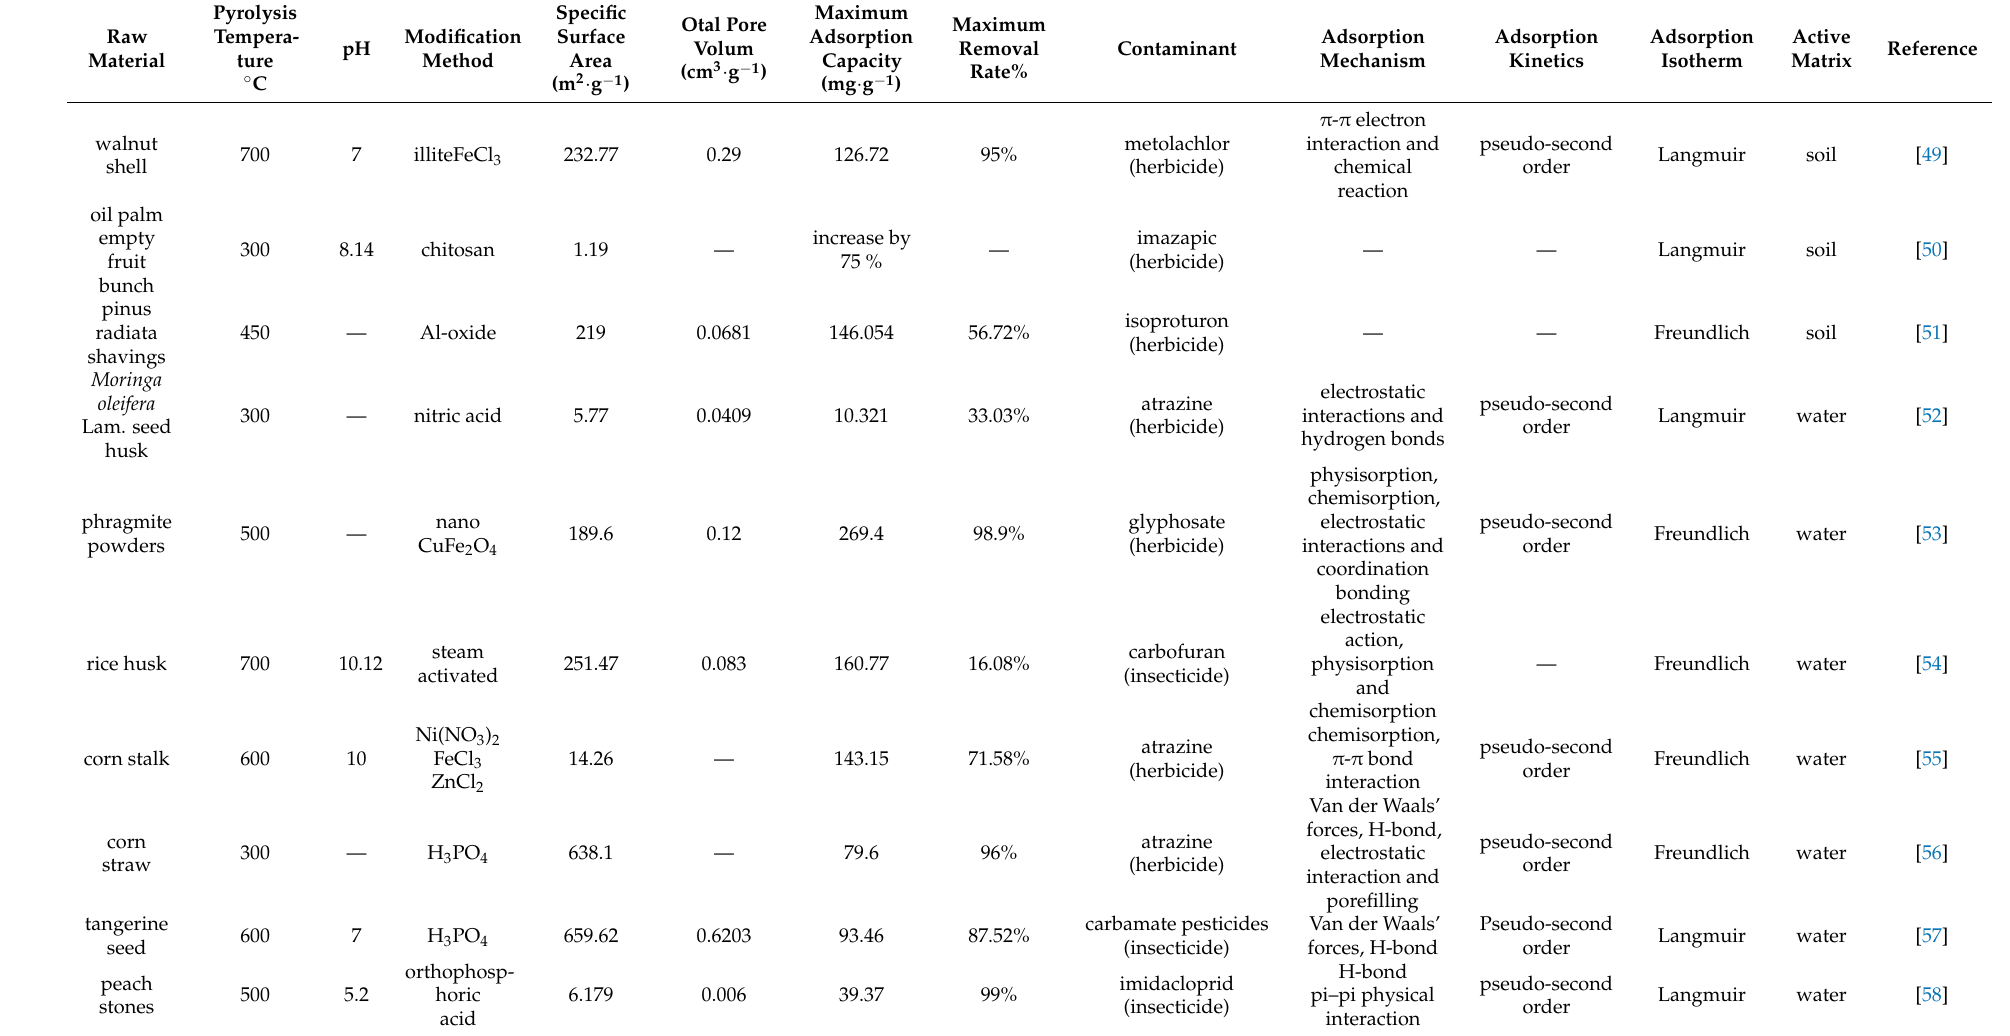
Table 2. The study of pesticides removed by modified biochar under different modification